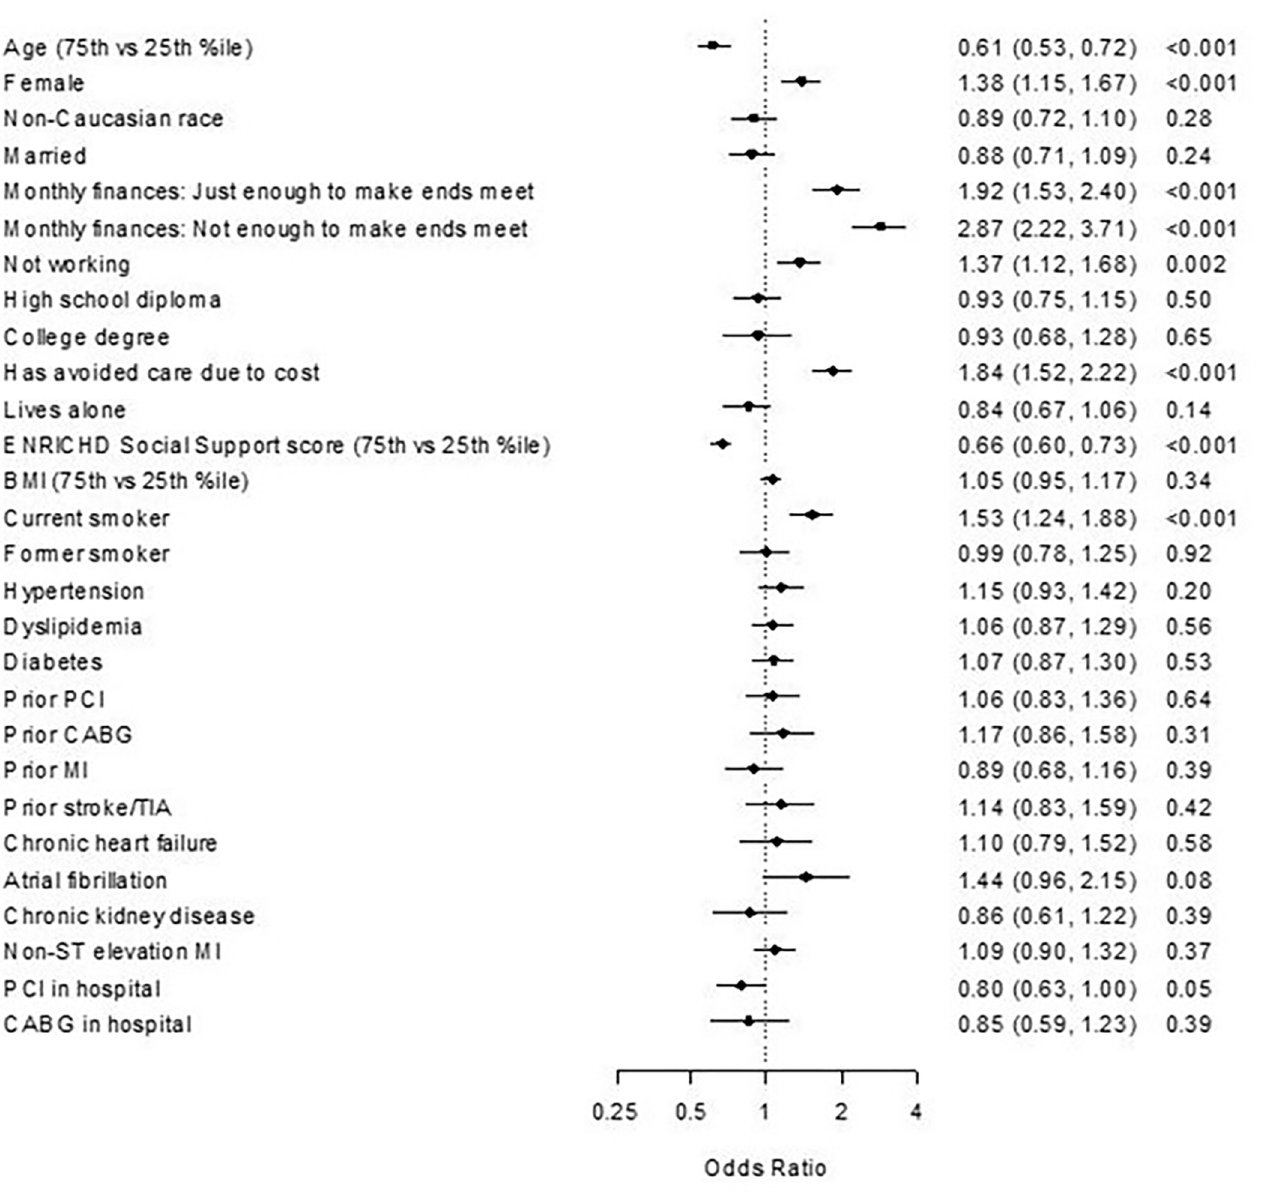
Fig 1. Independent predictors of chronic stress in the TRIUMPH